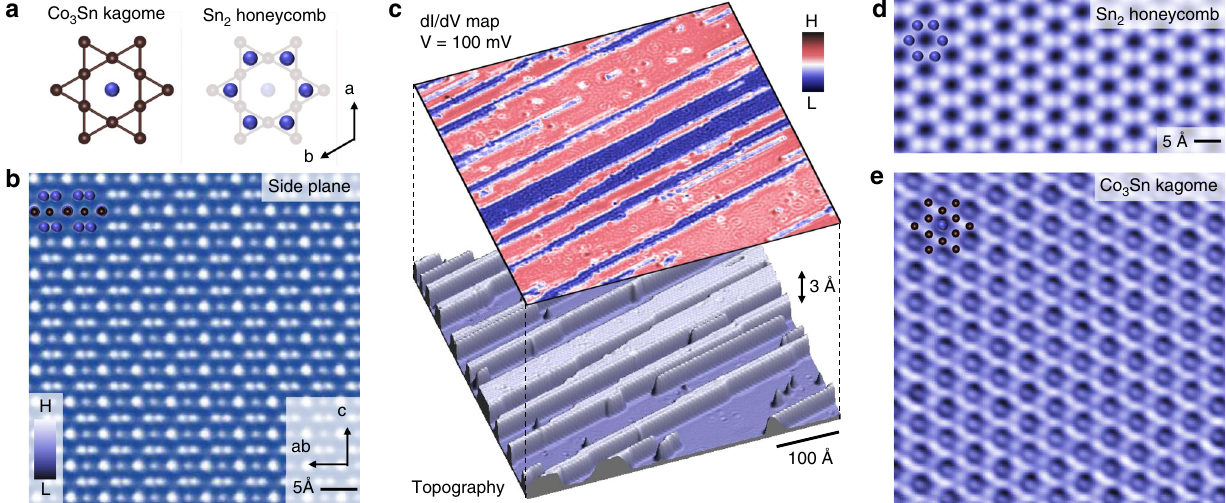
Fig. 1 Complete atomic-scale visualization of kagome lattice in CoSn. a Crystal structure of CoSn, which consists of a Co 3 Sn kagome layer (left) and a Sn 2 honeycomb layer (right). b Cross-sectional atomic resolution scanning transmission electron microscope image of CoSn, showing the lattice stacking along the c axis as illustrated in the inset. c Topographic image of a single atomic step (bottom) and the corresponding differential conductance map obtained at a bias voltage of 100 mV (top). d Atomically resolved Sn 2 surface with the corresponding atomic lattice structures. e Atomically resolved Co 3 Sn surface with the corresponding atomic lattice